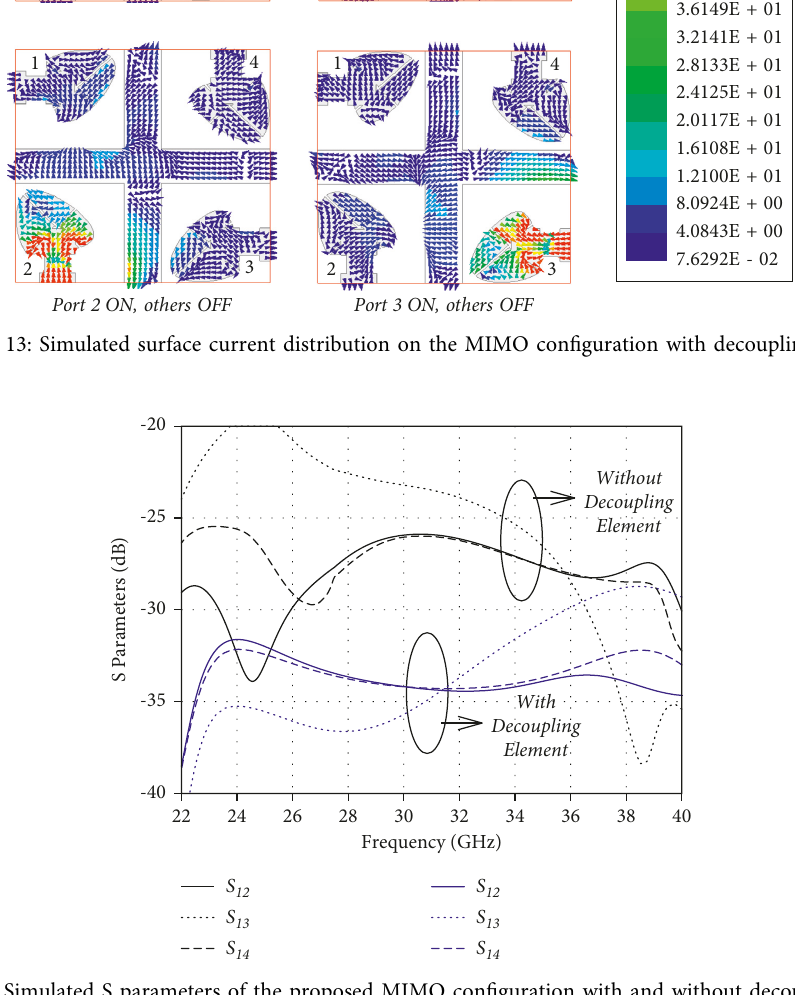
Figure 14: Simulated S parameters of the proposed MIMO configuration with and without decoupling